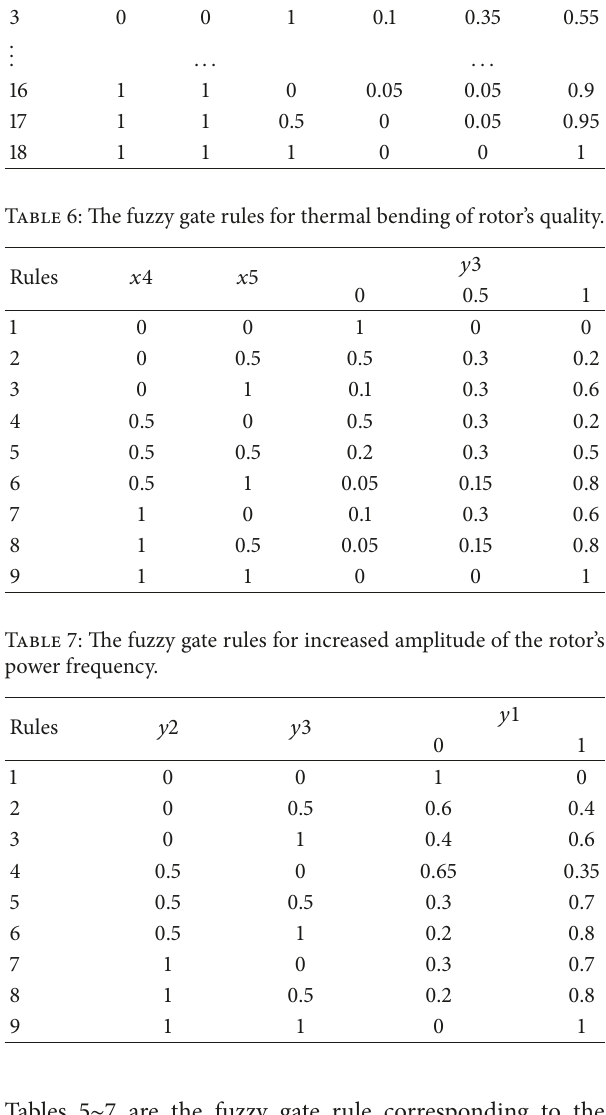
Table 4: Fault probability fuzzy subset of root node with fault state 1.